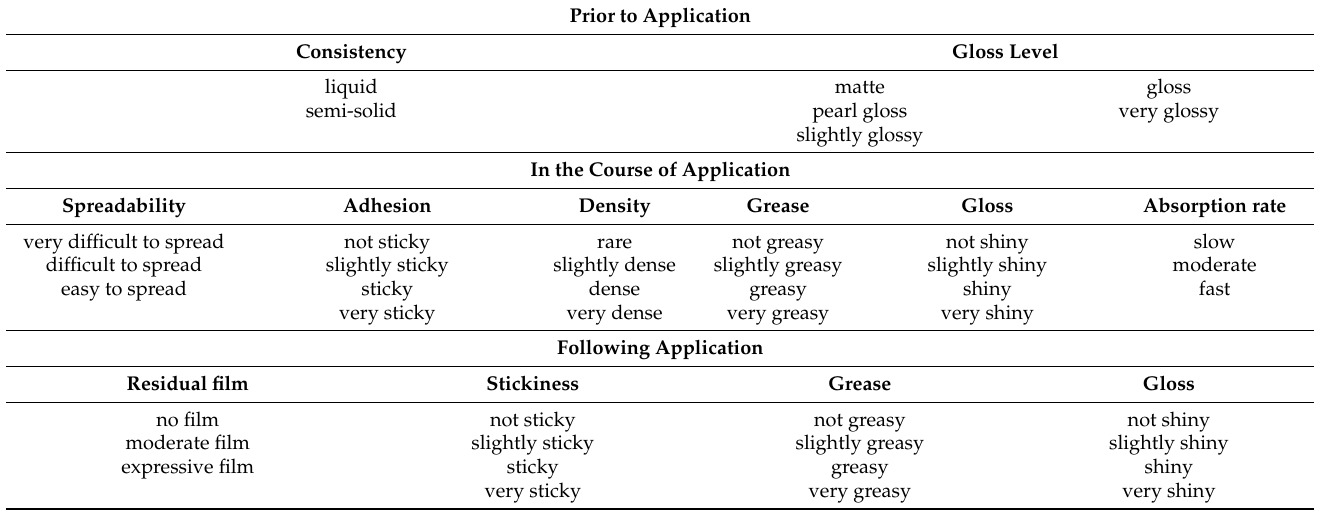
Table 2. Sensory evaluation